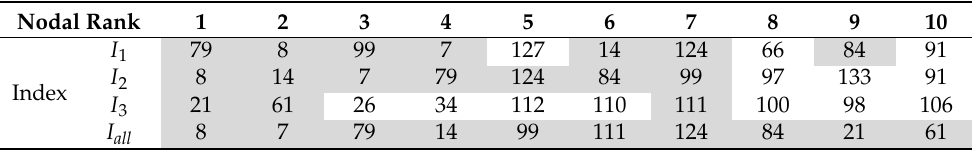
Figure 11. Importance values and classification of nodes obtained by TOPSIS. ( a ) Daily service ( I 1 ). ( b ) Post-earthquake rescue service ( I 2 ). ( c ) Network topology influence ( I 3 ). ( d ) Overall importance of all indices. Table 7. Top 10 ranked nodes by different